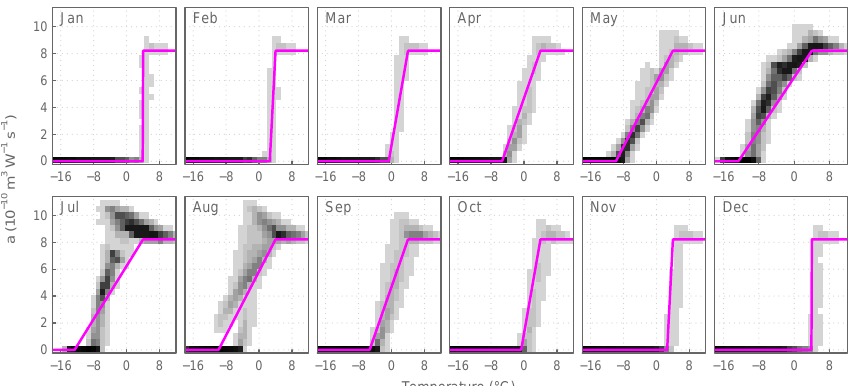
Figure 3. Monthly diagnostic values of the coefficient a versus temperature (shading represents density of points), along with the parame- terization given by Eq. (6) (magenta line).